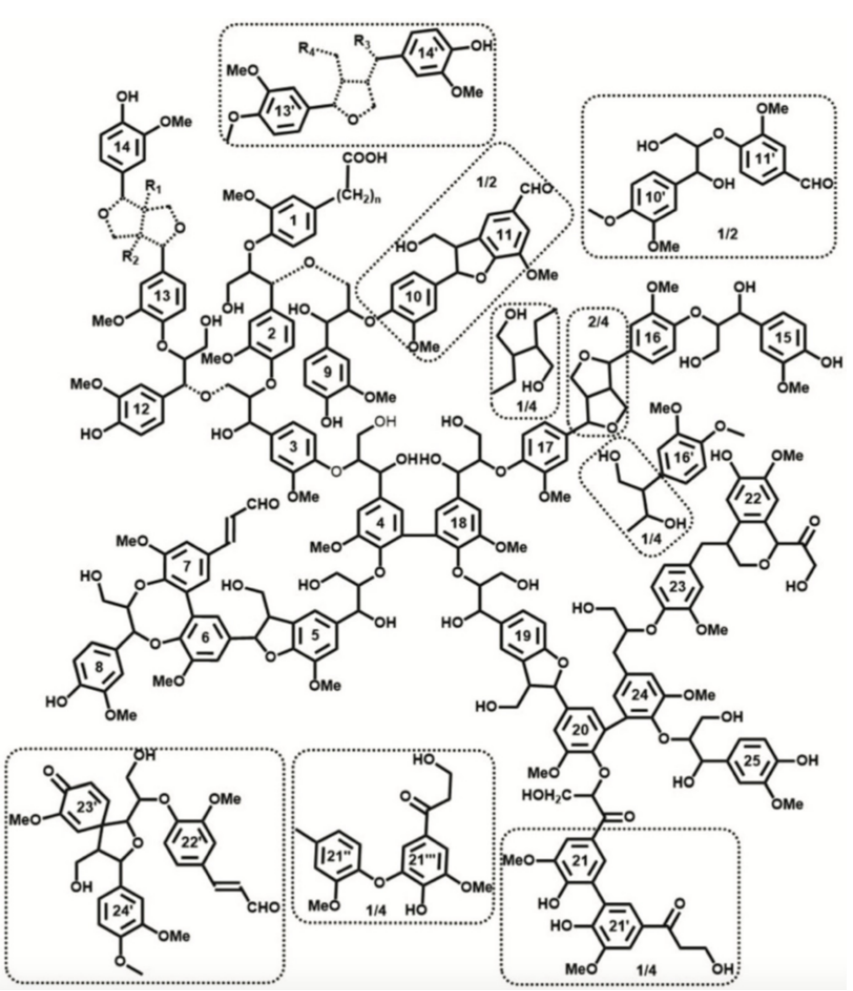
Figure 3. Tentative structural model of spruce milled wood lignin (MWL). Reproduced with permis- sion from